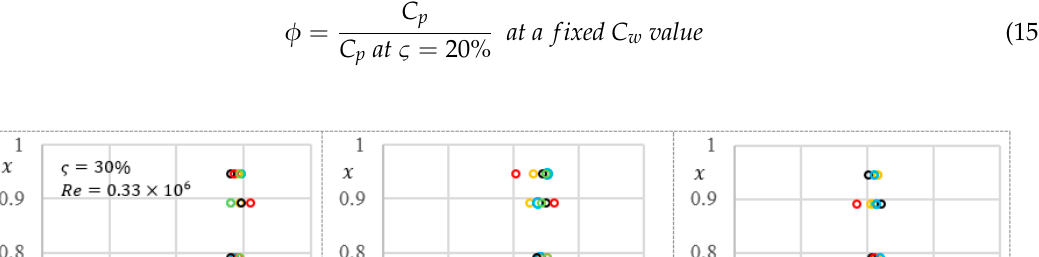
Figure 4. Radial distributions of 𝐶 (cid:3043) at 𝜍 = 20% from measurements.